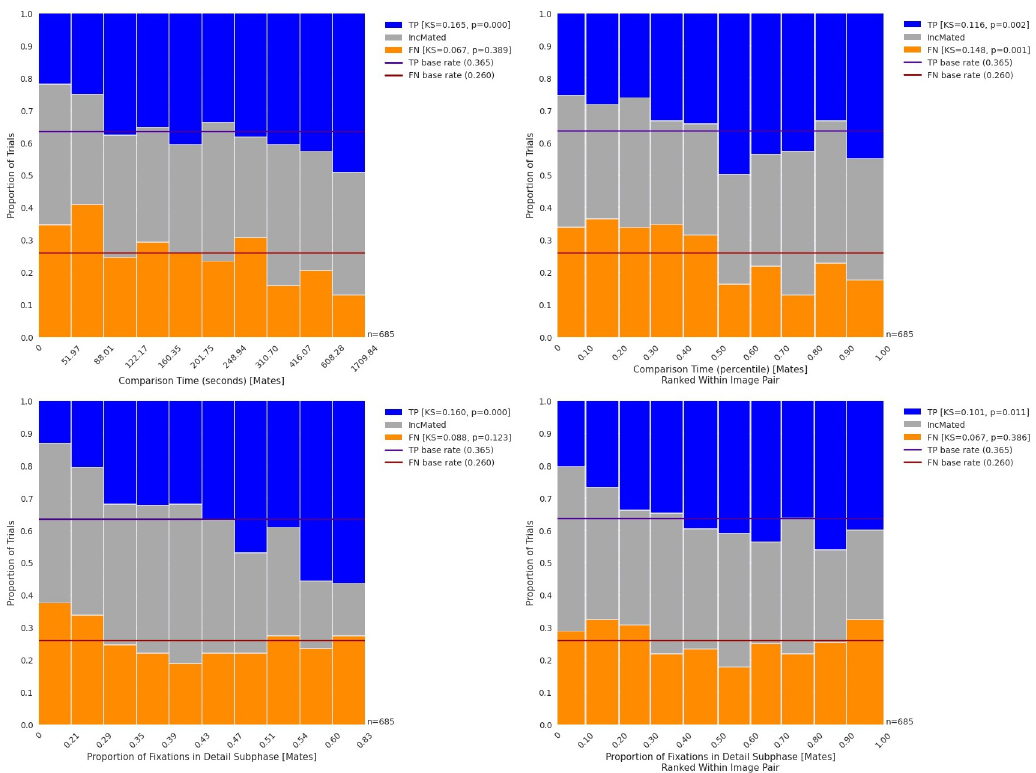
Fig 3. Distribution of outcomes by comparison time and proportion of detail fixations. Upper-left panel: Proportions of trials of TP, IncMated, and FN outcomes for different deciles of Comparison Time. TP outcomes tend to be associated with longer comparison times. Upper-right panel: Proportion of trials for different outcomes for comparison times that are ranked within each trial. TP outcomes tend to be associated with comparison times that are longer than most other trials on that image pair. Lower- left panel: Proportion of trials of different outcomes for Proportion of Fixations in Detail Subphase, demonstrating that TP outcomes are associated with a greater proportion of time spent in the detail subphase. Lower-right panel: Proportion of Fixations in Detail Subphase, ranked within each image pair, with weaker evidence for an association with